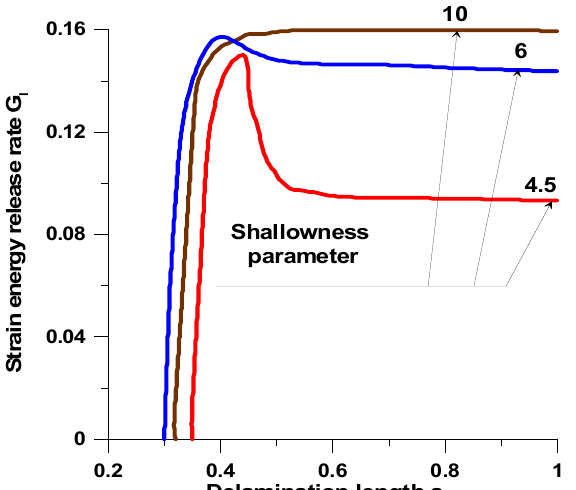
Figure 15. Distributions of the strain energy release rates G I for various shallowness parameter ρ .